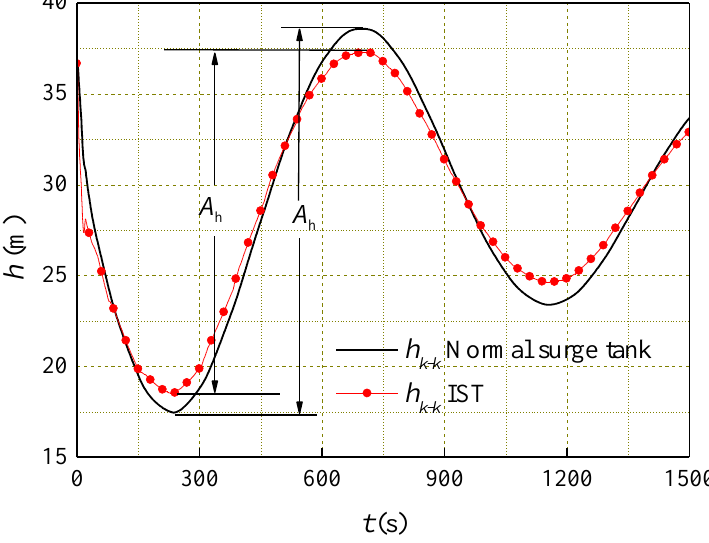
Figure 10. Extreme water head along the pipe after pump failure.